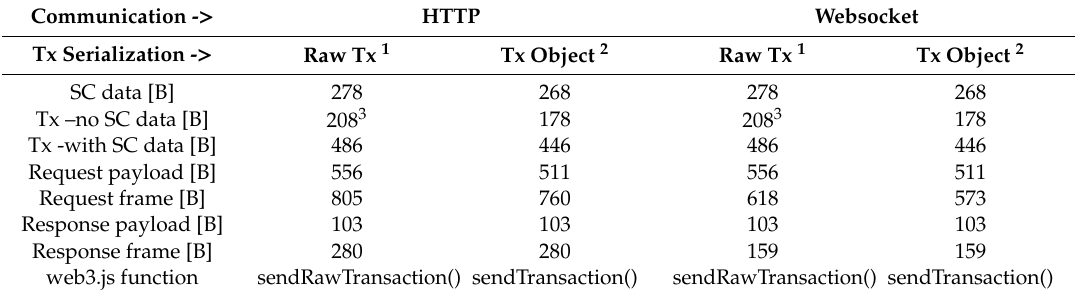
Table 5. Sizes of transactions to a smart contract address passed from the device to the client. Communication -